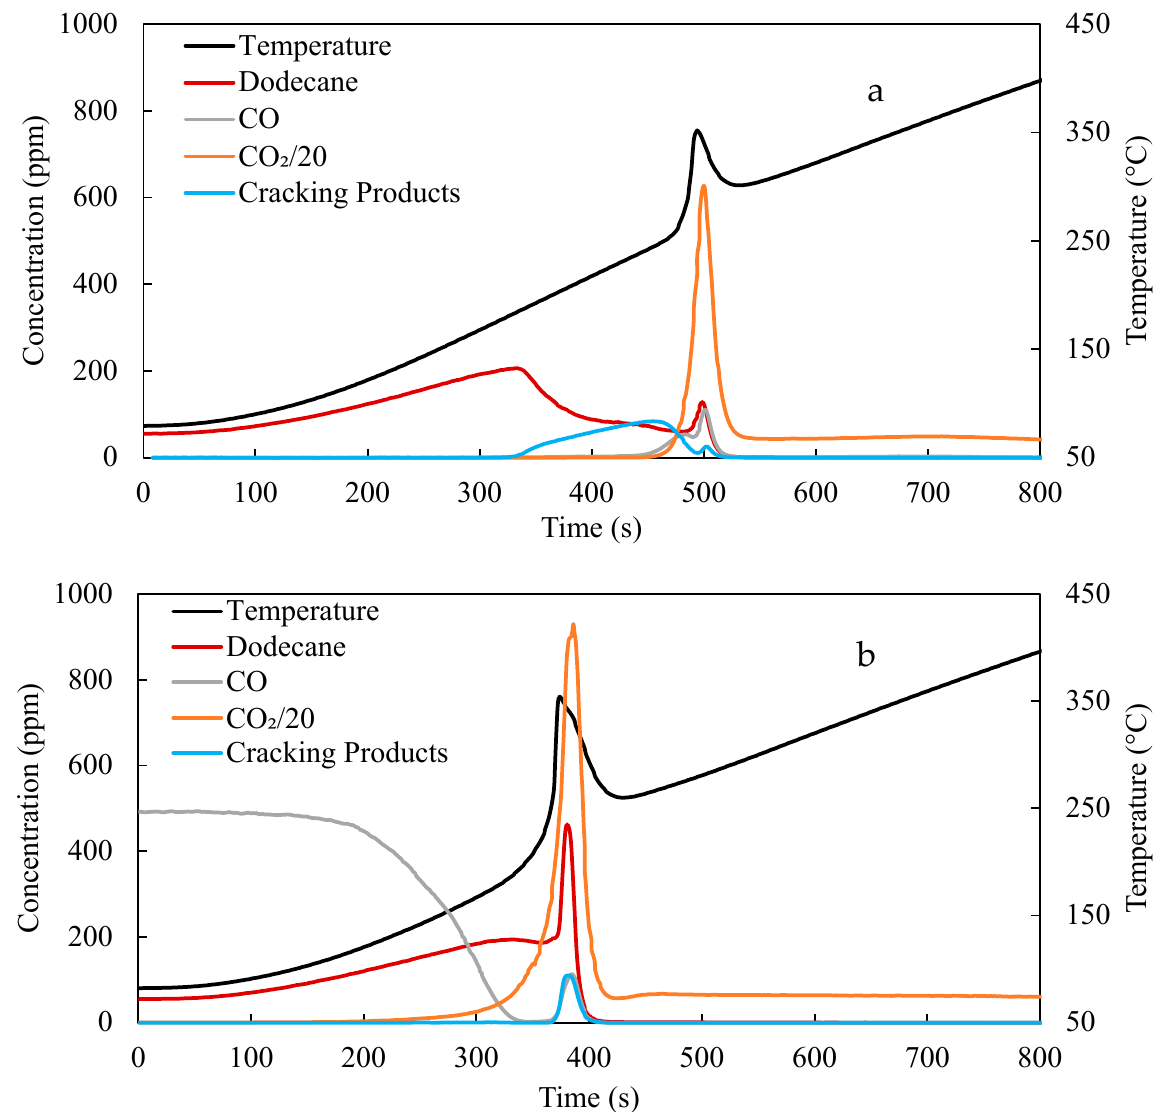
Figure 5. TPO Profiles of ( a ) Dodecane, ( b ) Dodecane + CO (58 ppm C 12 H 26 , 0 or 500 ppm CO, 6% H 2 O, 12% O 2 , balance N 2 ).